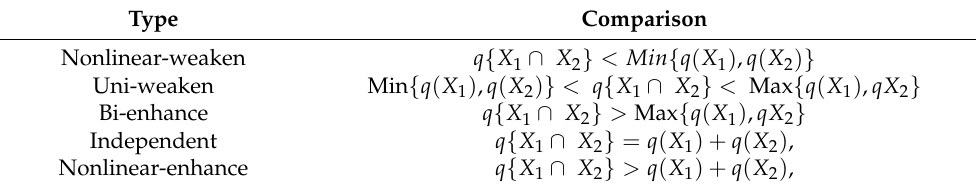
Table 2. Interaction relationships between